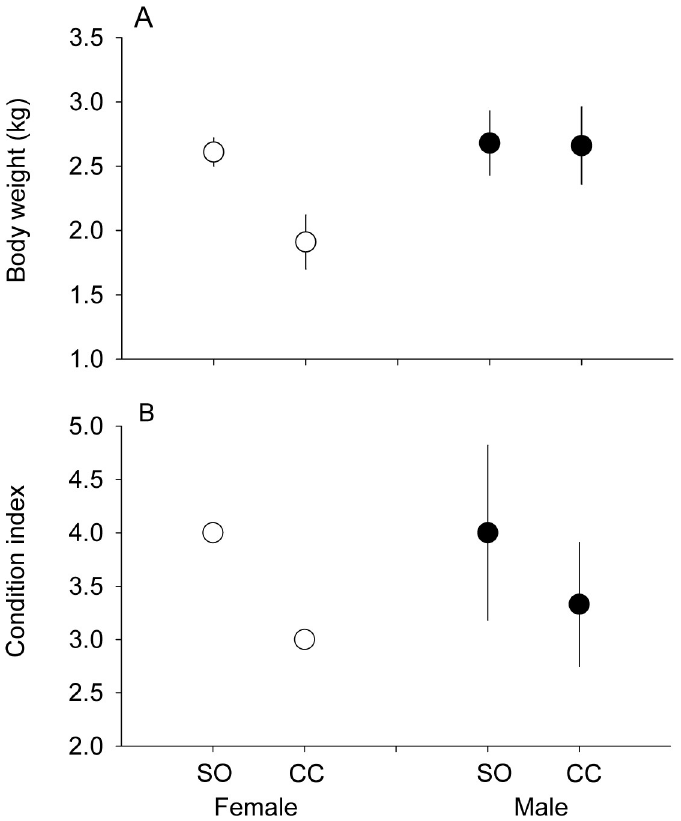
Fig 7. Comparison of (A) body weight (kg) and (B) condition index for female and male adult foxes between Soledad (SO) and China Camp (CC) locations. Mean ±